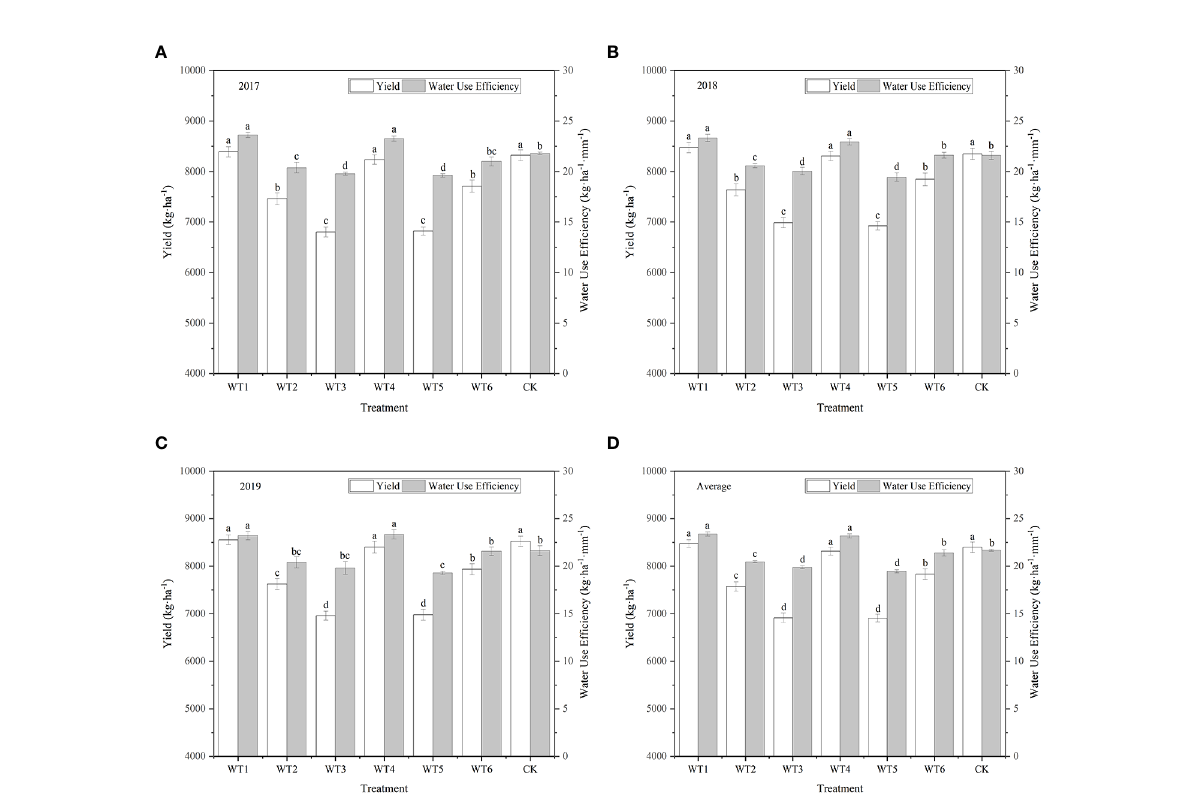
FIGURE 10 Yield and WUE of I. indigotica plants in different water de fi cit treatments. (A – D) describe the yield and WUE in 2017, 2018, 2019, and the average of these three years, respectively. Different lowercase letters in the same column indicate signi fi cant differences ( P < 0.05). Data were presented as mean ± SE (n =